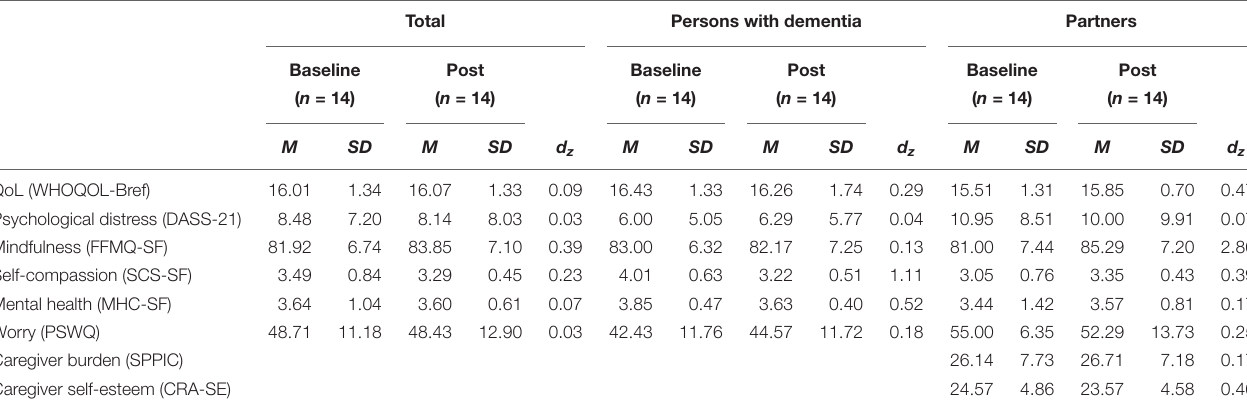
TABLE 4 | Characteristics, baseline and post-intervention scores of persons with dementia and partners.